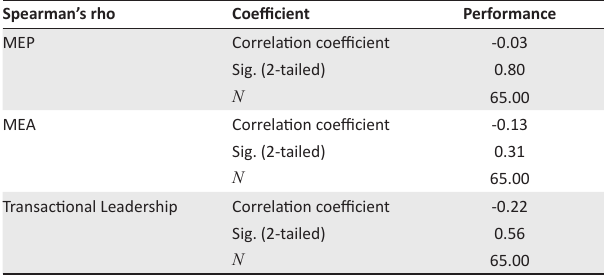
TABLE 10: Correlation analysis between transactional leadership and Individual Job Performance.